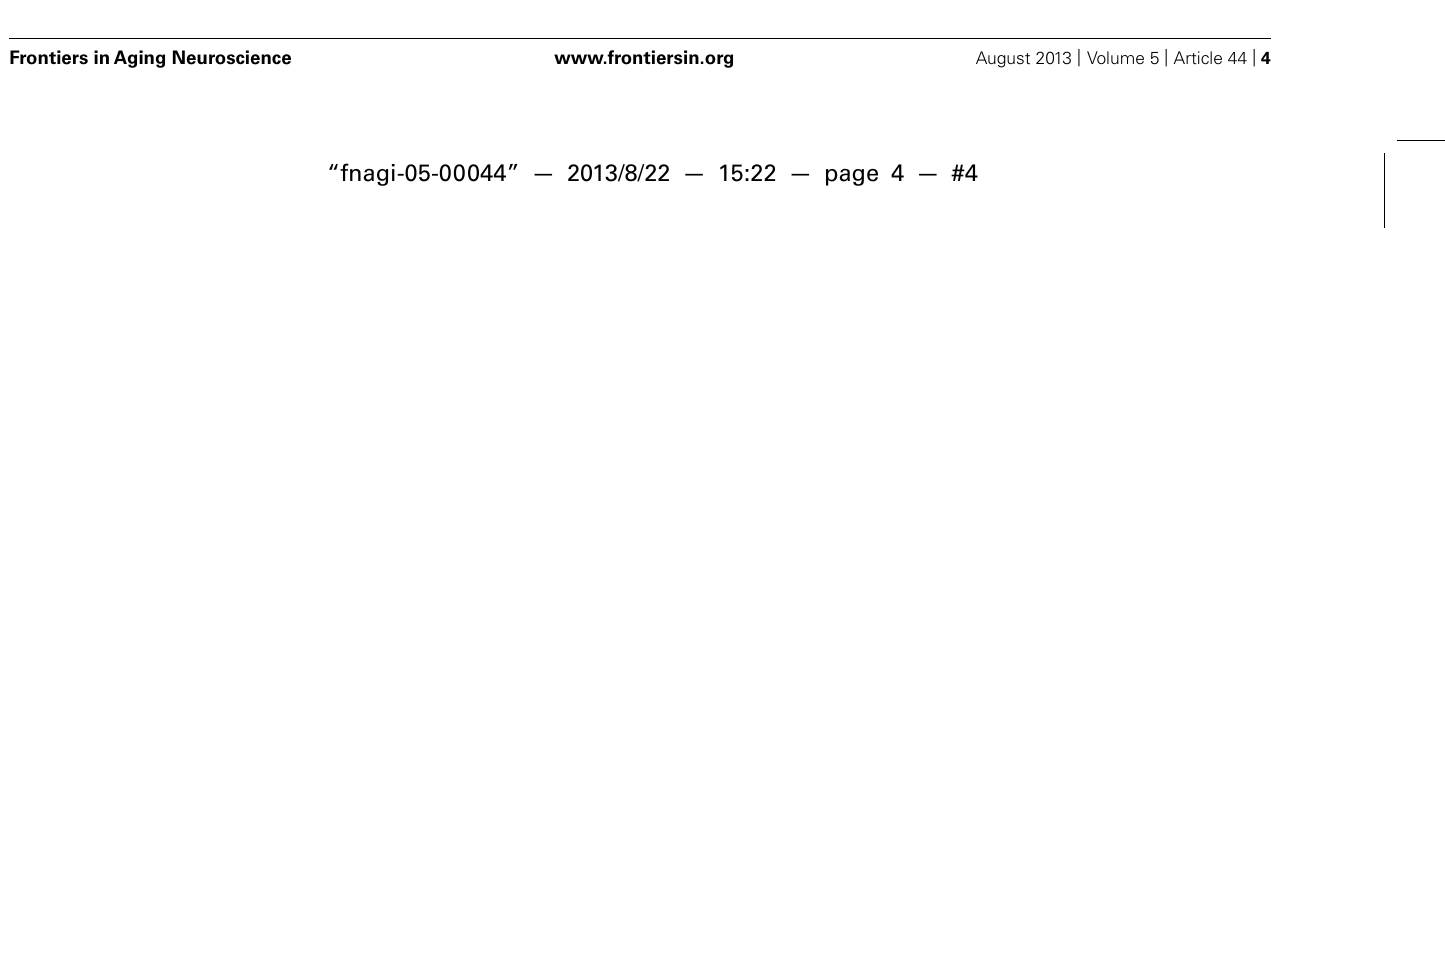
FIGURE 2 | Schematic diagram illustrating the proposed mechanisms of copper transport across the blood brain barrier (BBB) and blood cerebrospinal fluid barrier (BCB). (A) Copper transport under physiological conditions. Copper import into cells is via the major copper import protein CTR1.The proposed locations and orientation of ATP7A and ATP7B are shown. ATP7A is expressed in cerebrovascular endothelial cells that form the BBB but its expression is 3.4-fold higher in the choroid plexus than in the cerebral capillaries. In both choroid plexus epithelial cells and capillary endothelial cells of the brain, ATP7A predominantly localizes to the basolateral membrane. ATP7A facilitates copper transport from the blood across the BBB to the brain parenchyma. At the choroid plexus, ATP7A facilitates the removal of excess copper from the brain into the blood. Therefore, the BCB serves as the main pathway for eliminating excess brain copper. In contrast, ATP7B is concentrated at the apical membrane. At the CSF-facing apical membrane of choroid plexus epithelial cells, ATP7B may contribute to copper transport into the CSF and copper sequestration in the choroid plexus. Astrocytes are the first brain parenchyma cells to